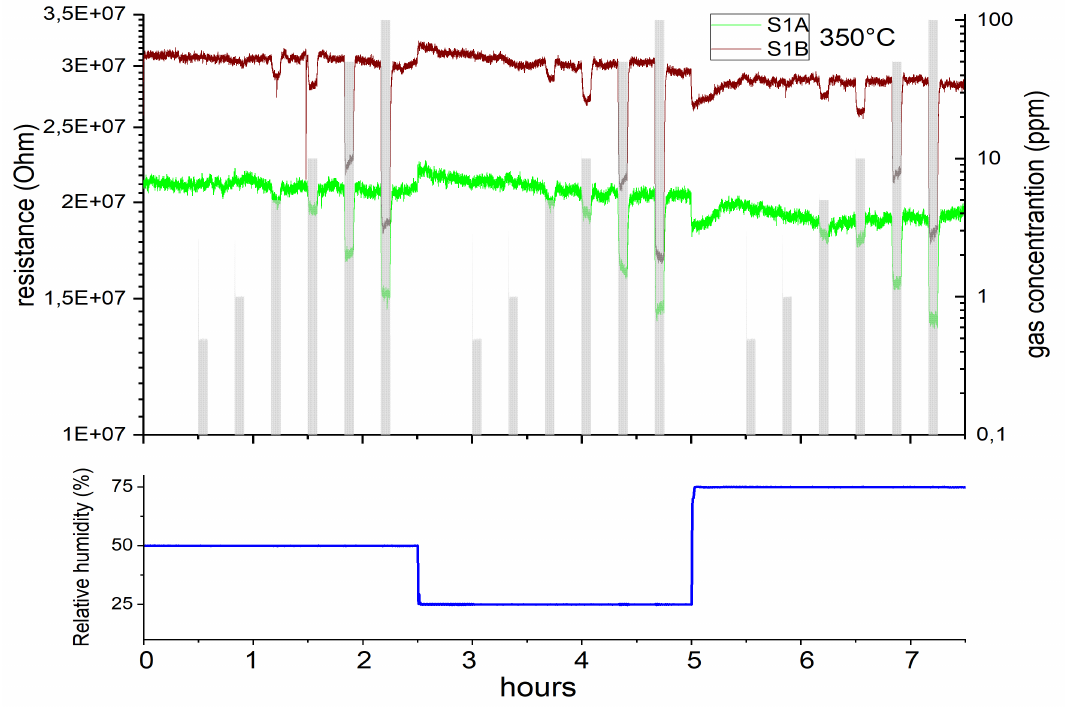
Figure 9. Resistance change of SnO 2 nanowires-based membrane sensors towards HCMix at 350 ◦ C: 1A and 1B — both of them prepared by the same technology.